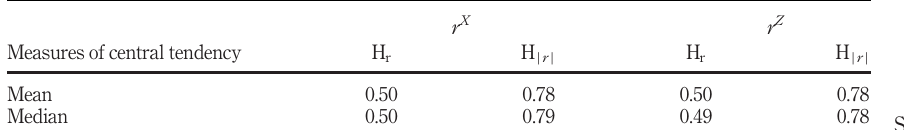
Table V. Scaling exponent